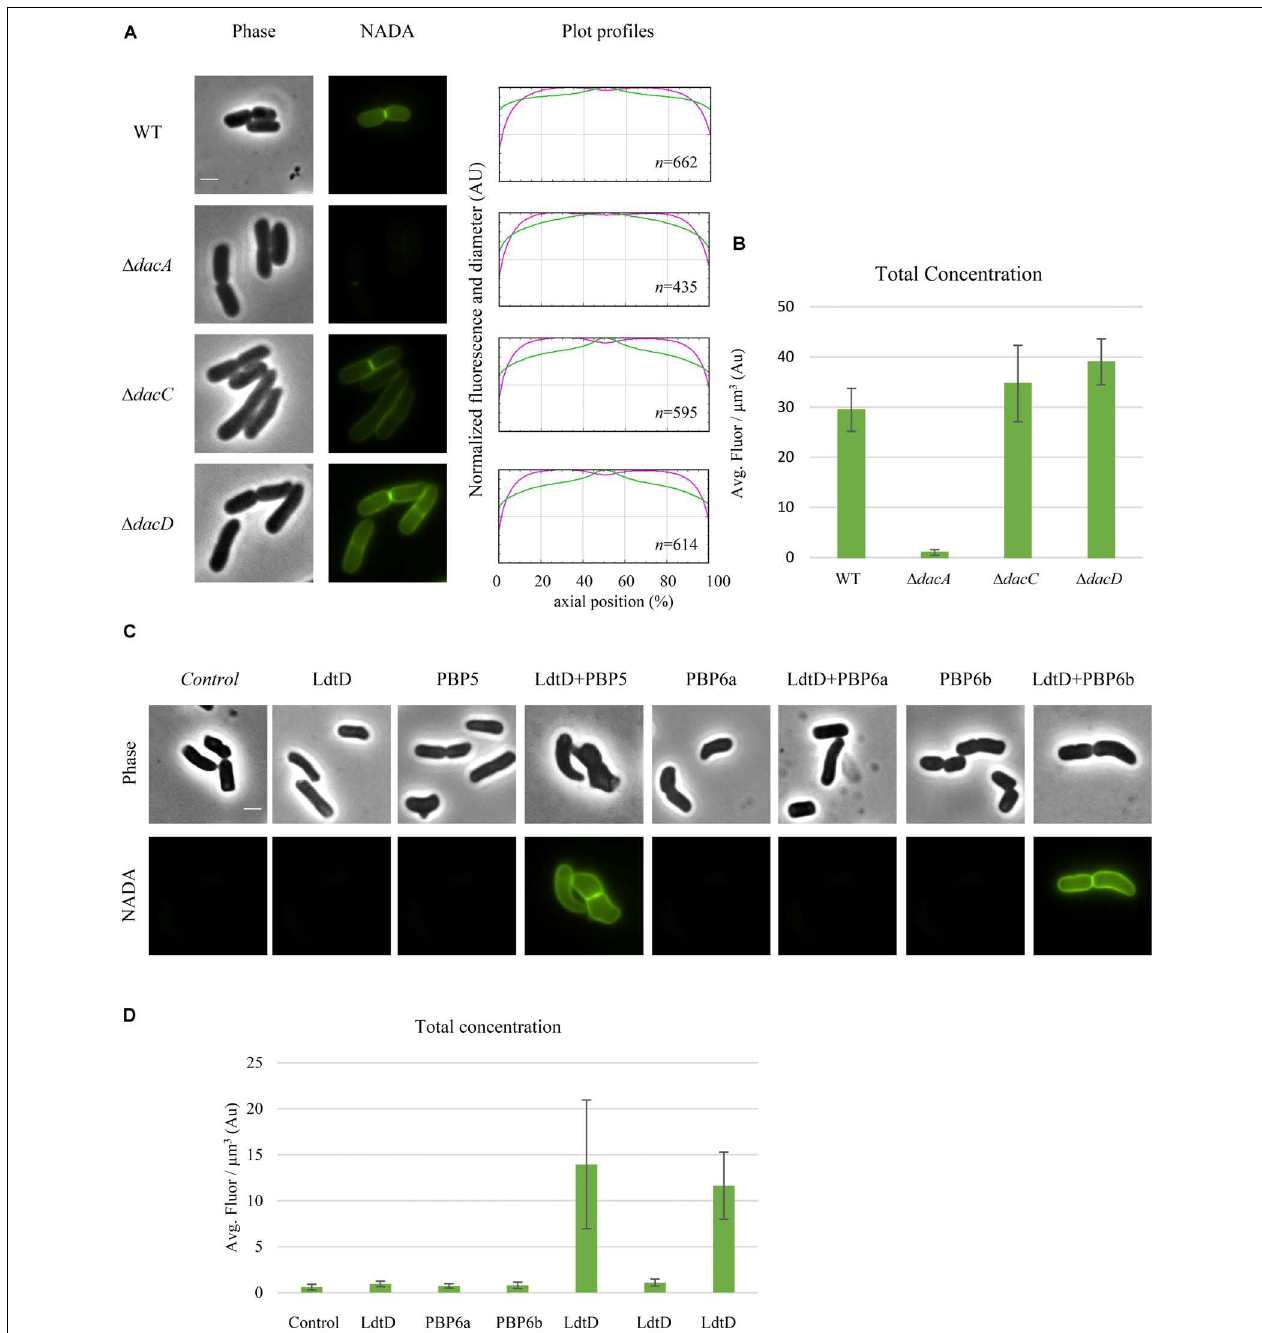
FIGURE 6 | Class C PBP activity is required for NADA incorporation by LdtD. (A) Phase contrast and fluorescence images of CS109, CS109 (cid:49) dacA (PBP5) expressing ldtD , CS109 (cid:49) dacC (PBP6a) expressing ldtD , and CS109 (cid:49) dacD (PBP6b) expressing ldtD labeled with a 0.5 mM NADA pulse of 2 min. Scale bar, 2 µ m. The right panel shows the average fluorescence profiles (green) and diameter (purple) per cell (from 0.0 to 1.0) plotted against normalized cell length (from 0 to 100%). n represents the number of cells analyzed. (B) Total concentration is the NADA fluorescence (signal per µ m 3 average cell volume). Quantification of the incorporated NADA in the CS109 strain, CS109 (cid:49) dacA expressing ldtD , CS109 (cid:49) dacC expressing ldtD , and CS109 (cid:49) dacD expressing ldtD . The values are mean ± SD of n number of cells. (C) Phase contrast and fluorescence images of BW5113D6LDTD dacA cells not expressing (control) or expressing ldtD , dacA , ldtD and dacA , dacC , ldtD , and dacC , dacD , or ldtD and dacD , labeled with 0.5 mM NADA. Scale bar, 2 µ m. The right panel shows the average fluorescence profiles (green) and diameter (purple) per cell (from 0.0 to 1.0) plotted against normalized cell length (from 0 to 100%). (D) Quantification of the total concentration of incorporated NADA in the BW25113 (cid:49) 6LDT (cid:49) dacA cells not expressing (control) or expressing ldtD , dac A, ldtD and dacA , dacC , ldtD , and dacC , dacD , or ldtD and dacD . The values are mean ± SD of n number of cells.